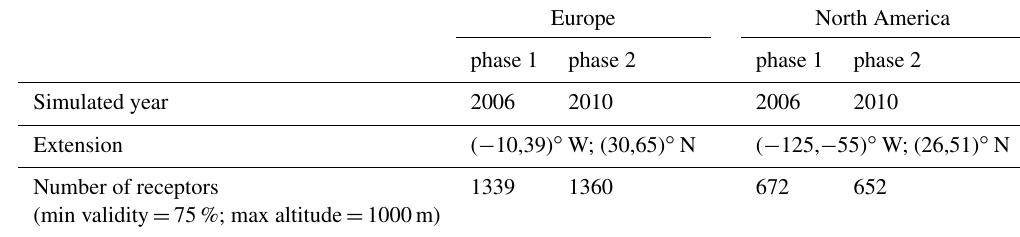
Table 1. Features of the modelled